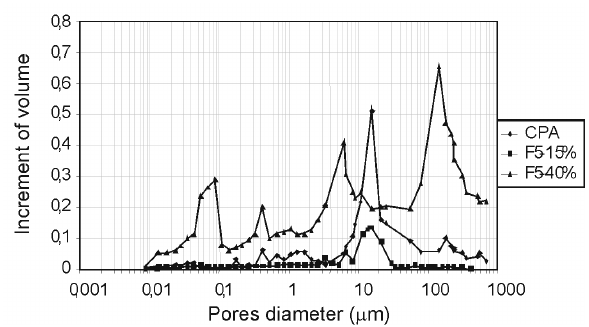
Fig. 7. Distribution of the pores according to the fine rate (F5 fillers; W/B=0,24)